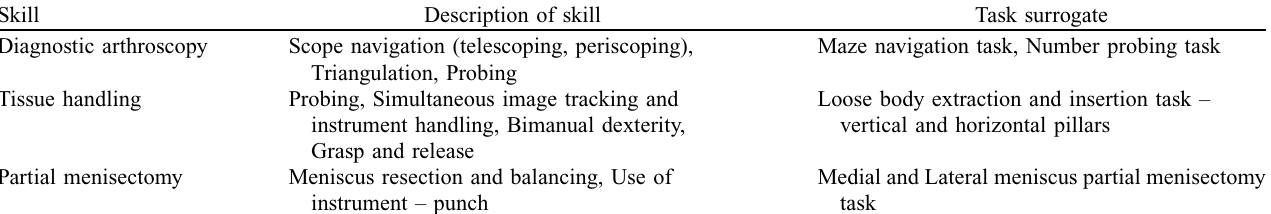
Table 2. Description of basic arthroscopy skills and surrogate tasks on the ‘‘FAST’’ workstation.